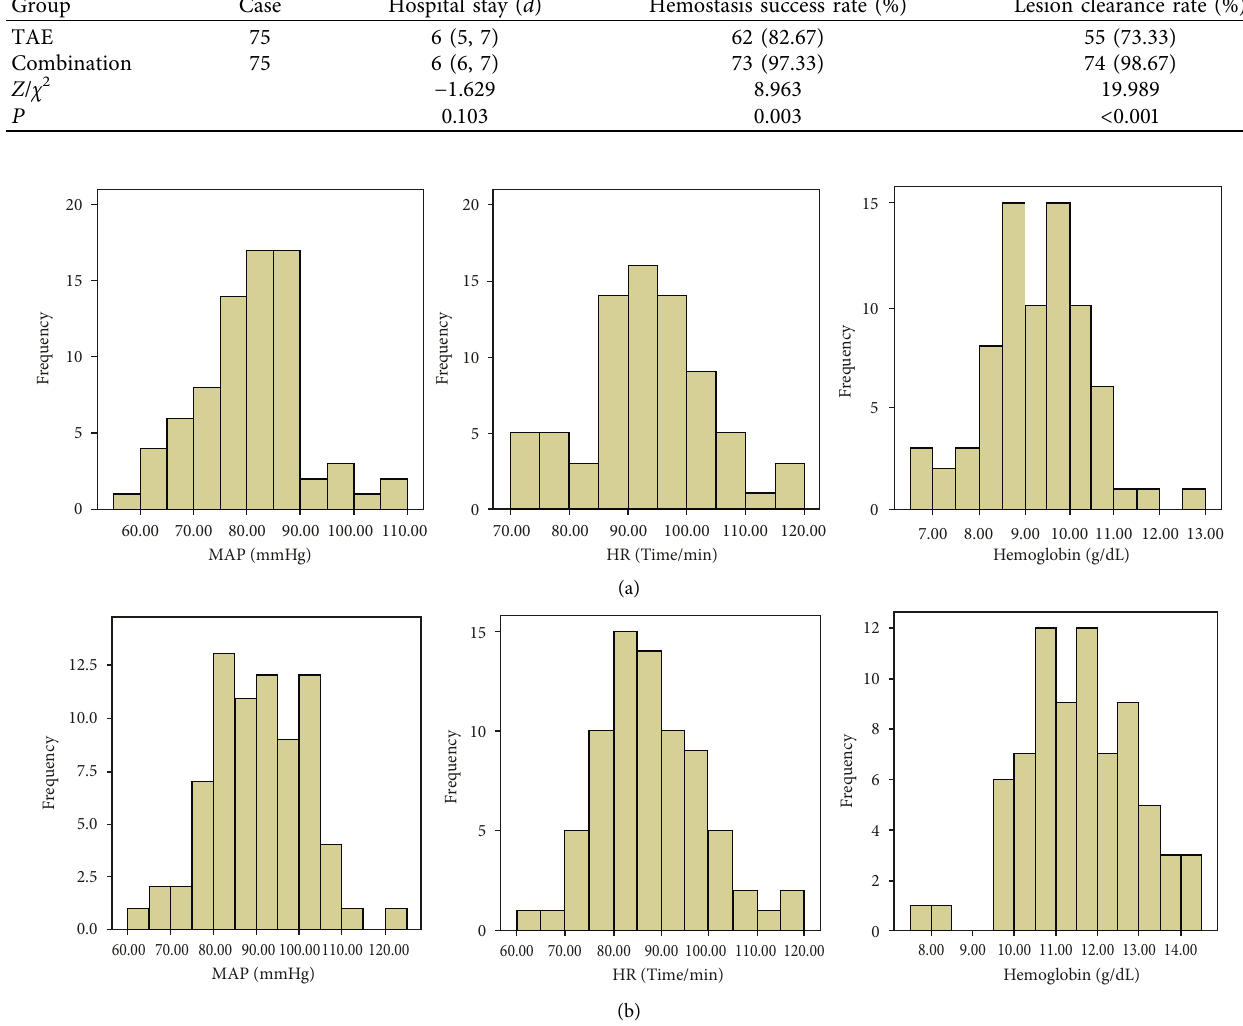
Figure 1: Level distribution of postoperative hemostatic effect-related indicators in the two groups. (a) Level distribution of postoperative hemostatic effect-related indicators in TAE group; (b) level distribution of postoperative hemostatic effect-related indicators in combination group. Table 2: Comparison of hemostatic effects between the two groups ( x ± s ). Group